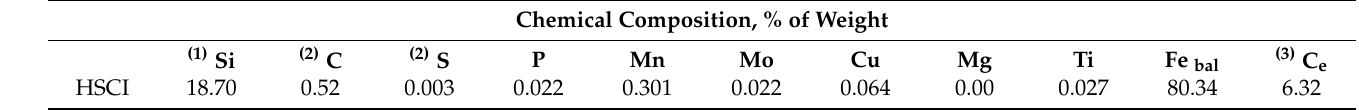
Table 2. Chemical composition of high-silicon cast iron. Chemical Composition, % of